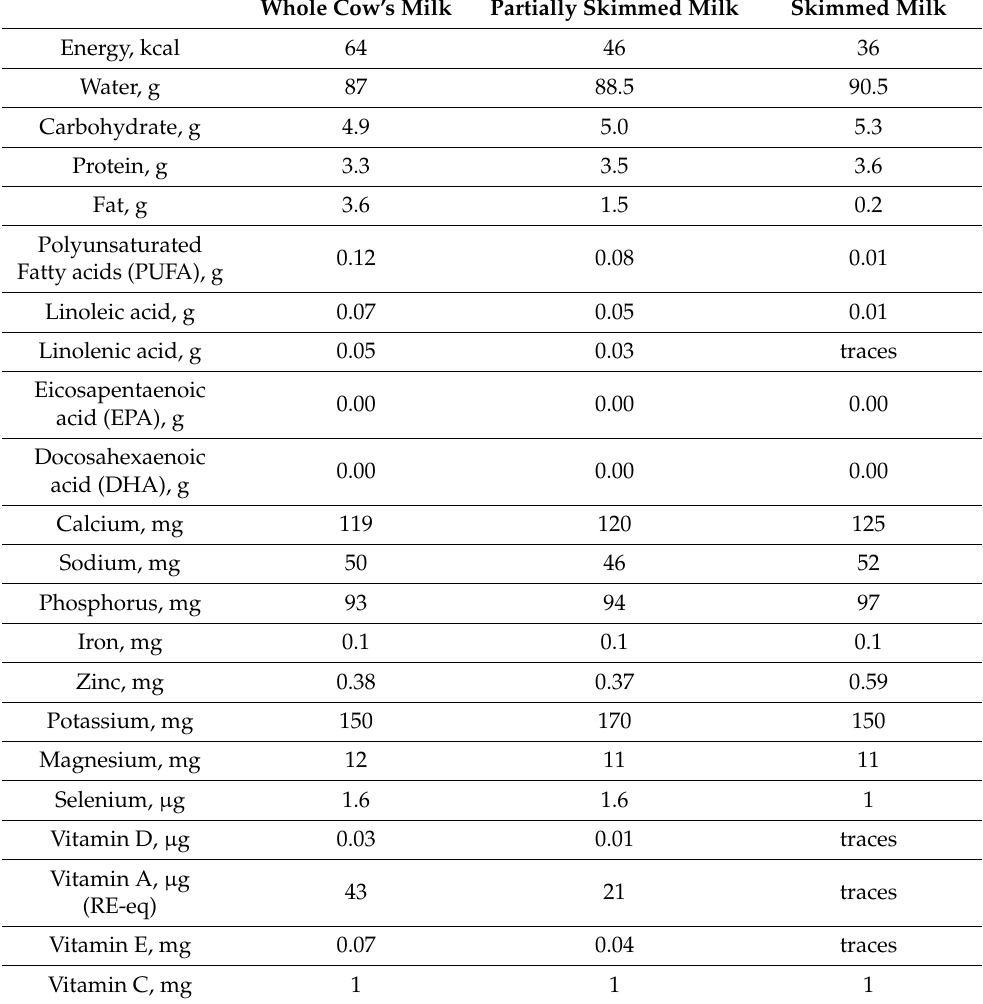
Table 2. Nutrient content in 100 g of different type of commercially available cow’s milks 1